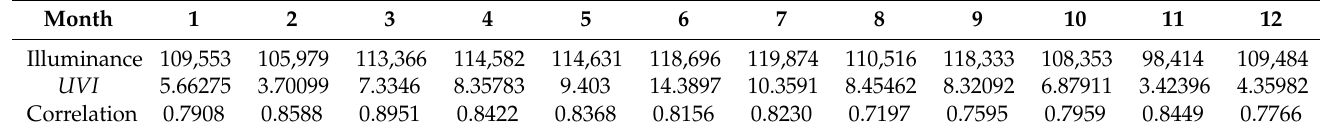
Table 1. Pearson’s correlation between the monthly average illuminances and the UVI (Ultraviolet